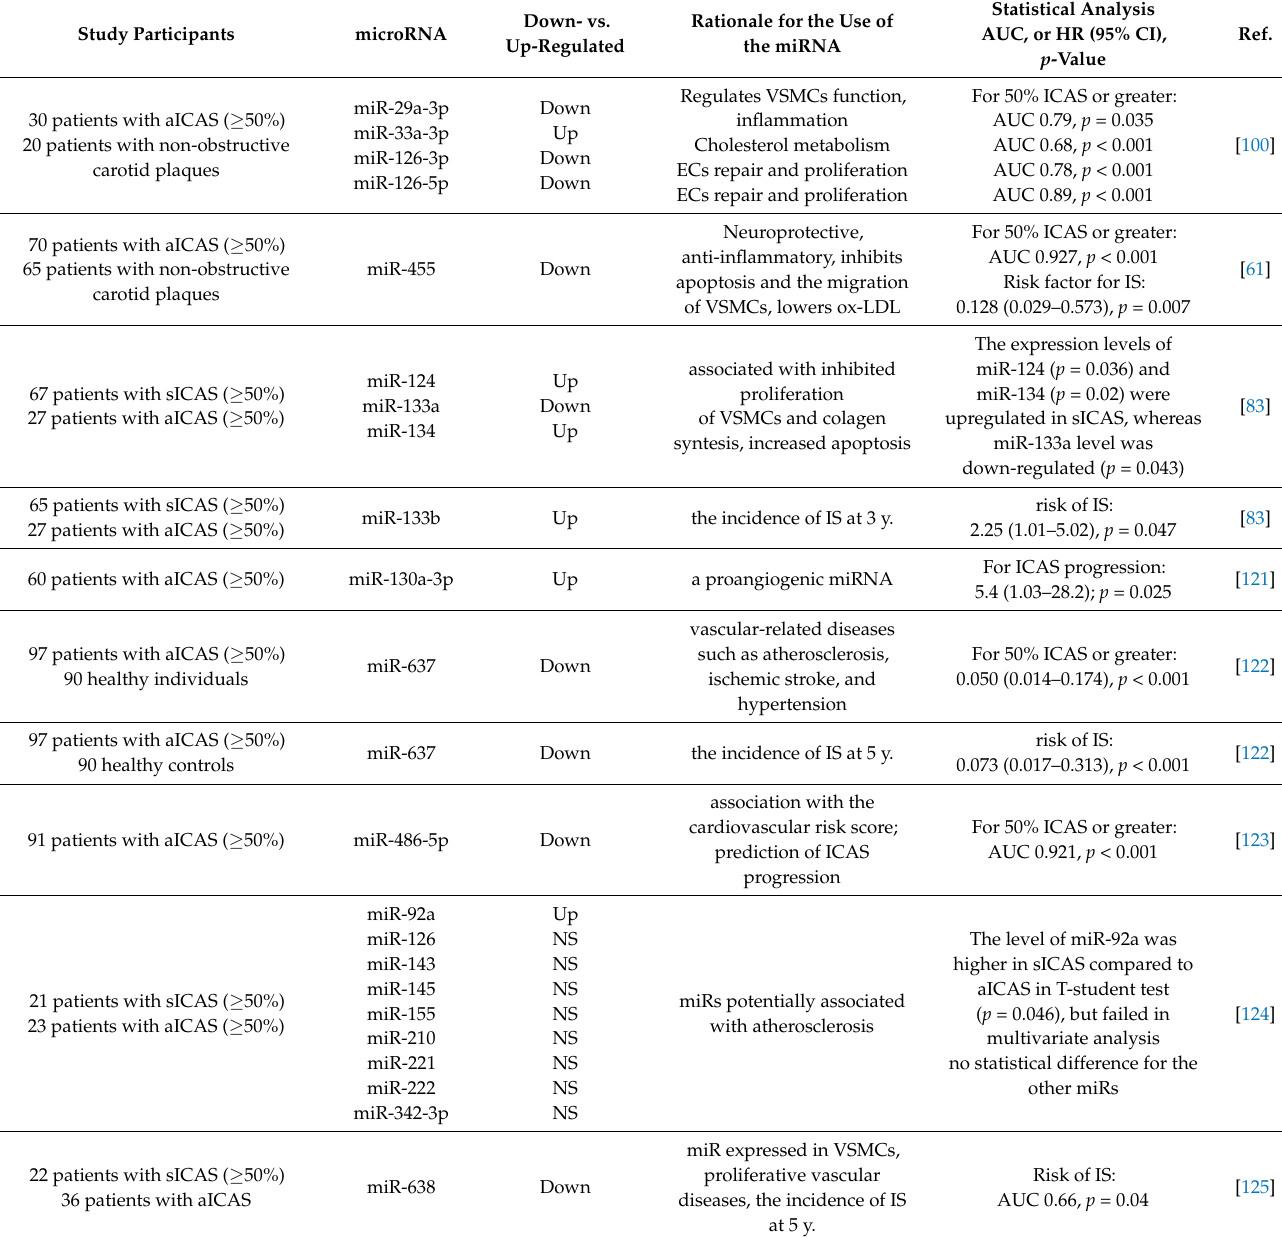
Table 2. Serum/plasma microRNAs that are potentially diagnostic for the degree of ICAS, can differentiate between patients with asymptomatic versus symptomatic ICAS, or are prognostic for risk of ICAS-related